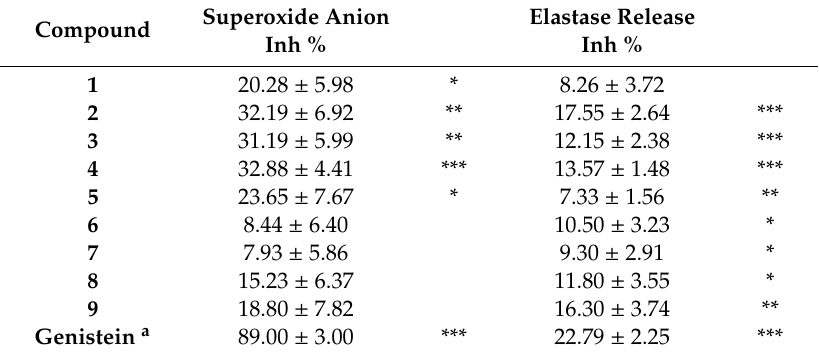
Table 2. Inhibitory e ff ects of compounds 1 – 9 on superoxide anion generation and elastase release in formyl-methionyl-leucyl-phenylalanine (fMLF) / cytochalasin (CB)-induced human neutrophils.